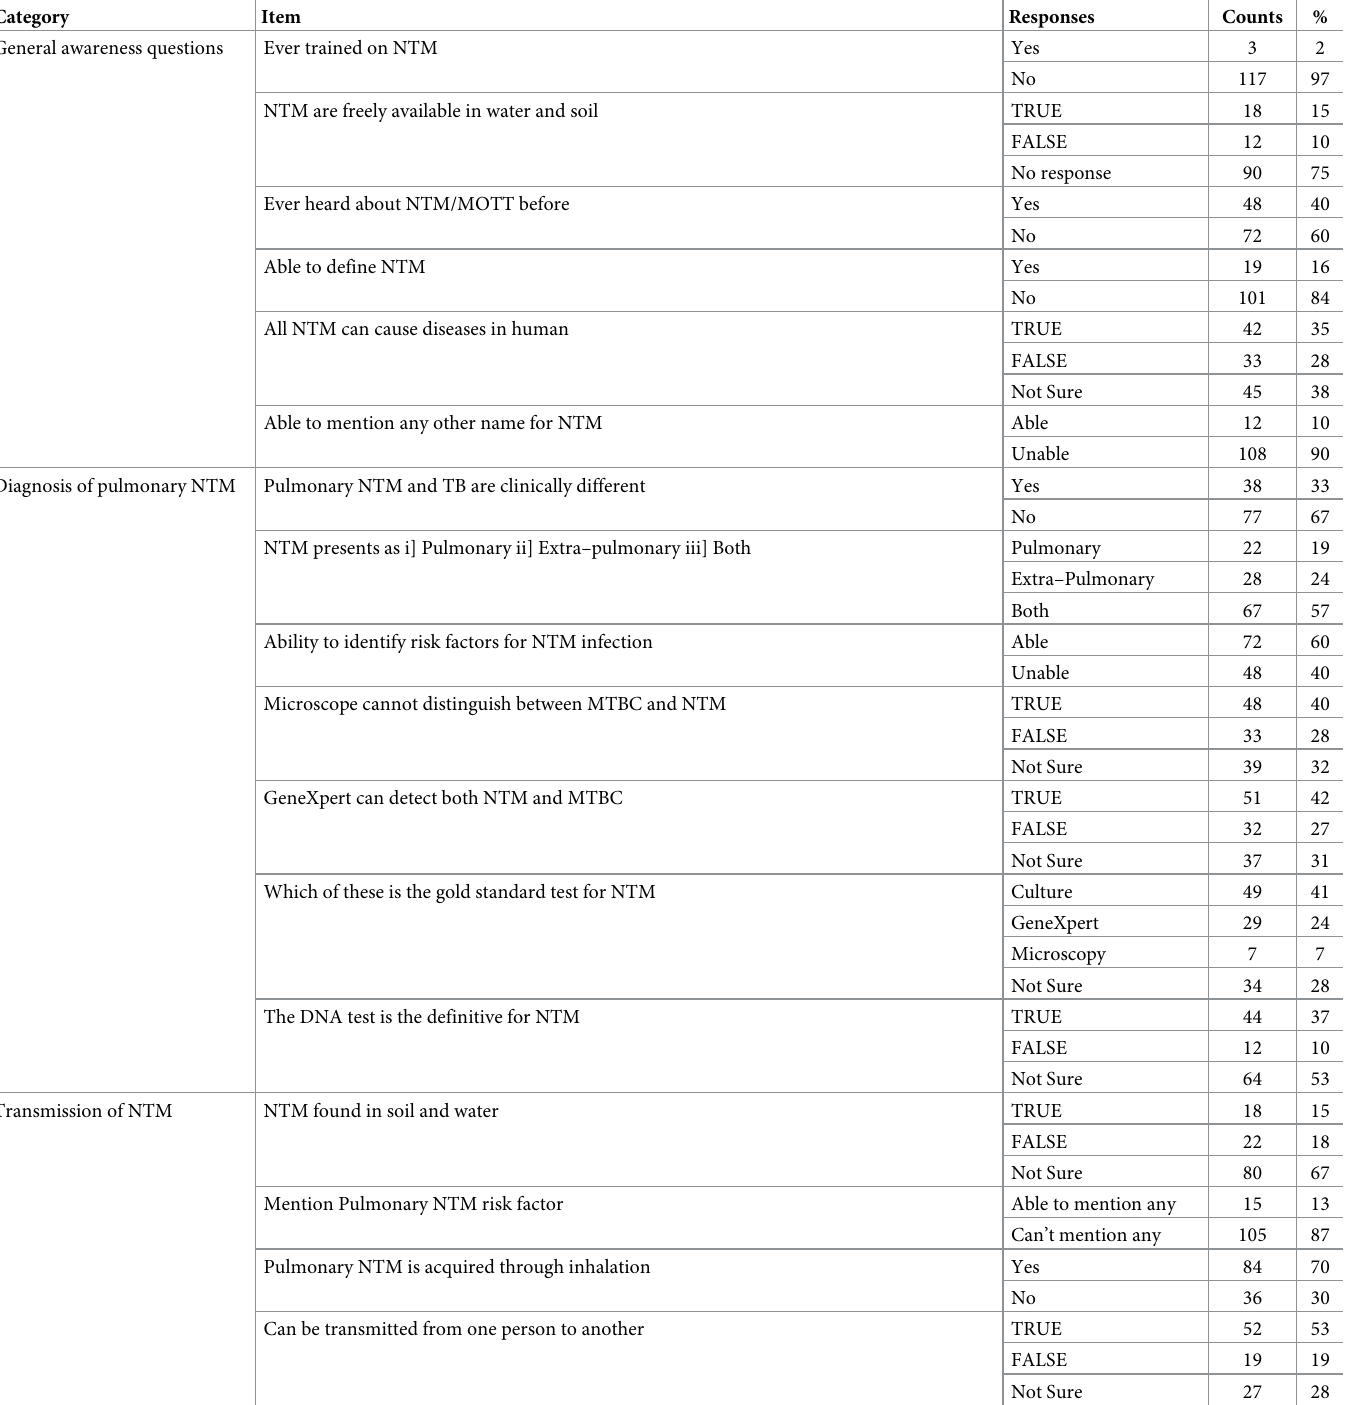
Table 4. Participants’ responses to the survey